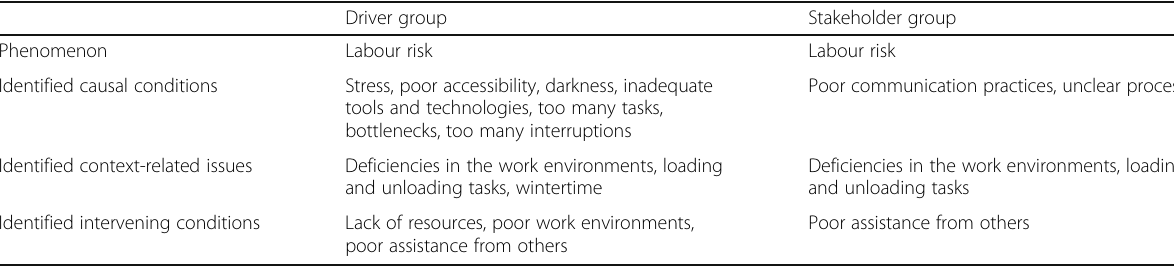
Table 2 A summary of the axial coding phase Driver group Stakeholder